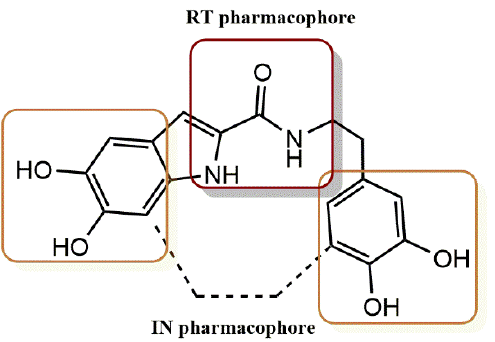
Figure 16. RT and IN pharmacophores of new active synthesized compound 14 .